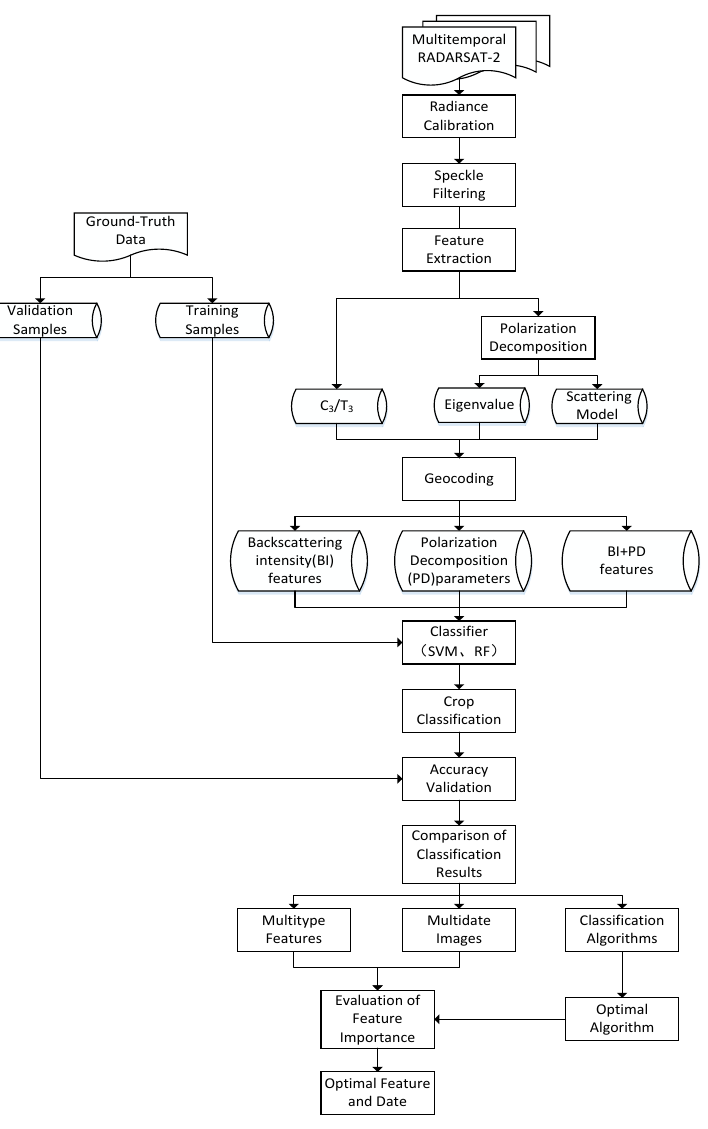
Figure 3. Workflow of the dryland crop classification methodology.